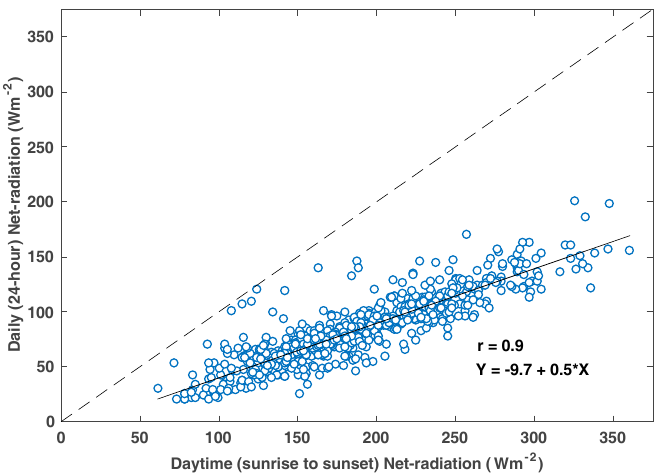
Figure 7. Relationship between mean annual daytime (sunrise to sunset) net-radiation and daily (24-h) net-radiation from measurements.